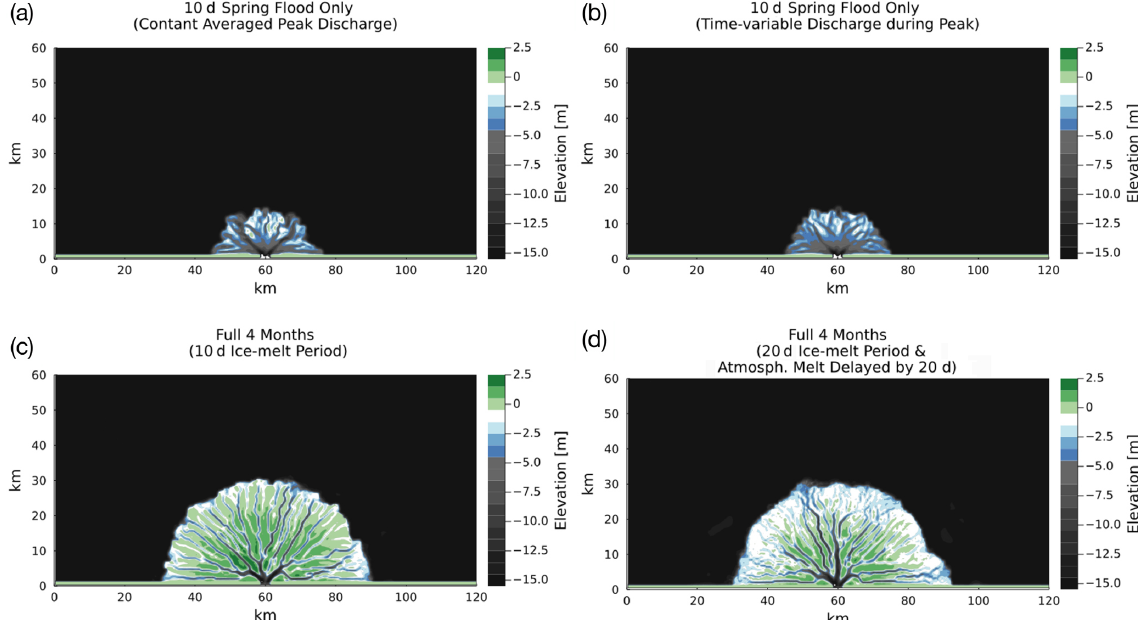
Figure 9. Bed elevations of deltas produced by running ArcDelRCM.jl for 150 model years on Lena Delta-like spatial scales (see text in Sect. 3.4), with input discharge derived from daily measured values from GRDC Station Data 2903430 (2018). The top row (a, b) features deltas produced by running model years of 10d each, which is also the ice-melt period. Discharge in these 10d cases is taken from the peak 10d of the time series and either (a) averaged and used as a constant value or (b) used directly as a 10d discharge time series. The bottom row (c, d) features deltas that are produced by 4-month model years (June to September), using the full input discharge time series for the corresponding period. The case in panel (c) kept the ice-melt period of 10d, whilst the case in panel (d) has an ice-melt period of 20d and a delayed onset of atmospherically induced melting by 20d from the start of each model year. Note the difference in size between the top and bottom rows and the ramp feature around the delta in panel (d)